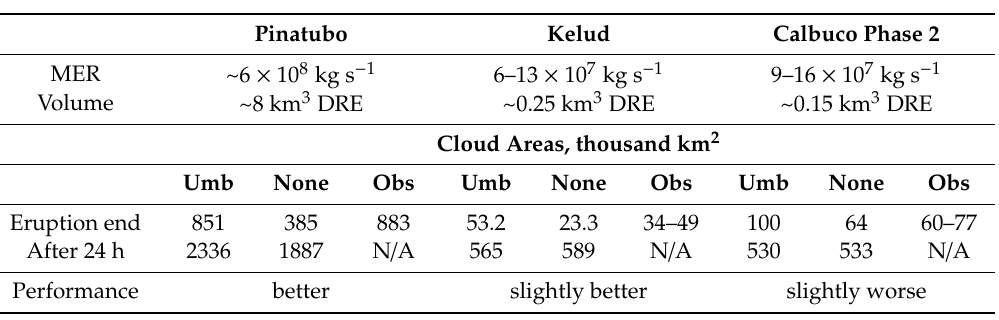
Table 5. Summary of results for Pinatubo, Kelud and Calbuco. Mass eruption rate (MER) is based on best-fit curves in Figure 2b, Figure 4b, and Figure 5b. Volume is based on considerations given in the text. The column headings “Obs”, “Umb”, and “None”, give the areas of clouds observed (Obs), predicted by models that consider umbrella growth (Umb), and by models that do not consider umbrella growth (None). The “performance” row assesses qualitatively whether simulations that consider umbrella growth are better or worse at reproducing the size and shape of the observed cloud. “N / A” indicates that cloud-area data were not analyzed at the times indicated. “N / A” indicates that cloud area observations were not analyzed at the times